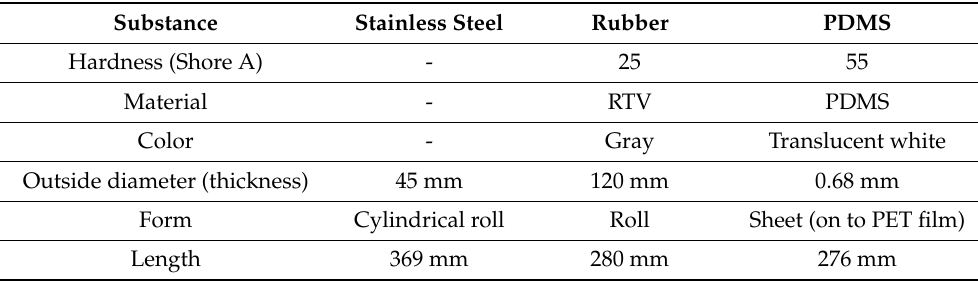
Table 2. Properties of the